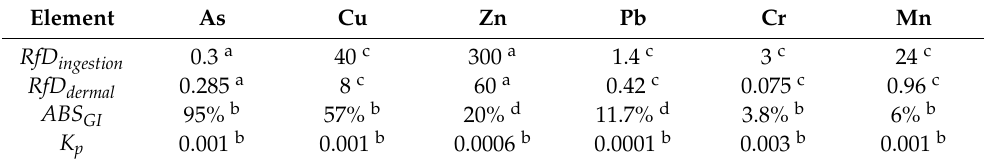
Table 3. RfD ingestion , RfD dermal , ABS g , and K p values of trace elements.